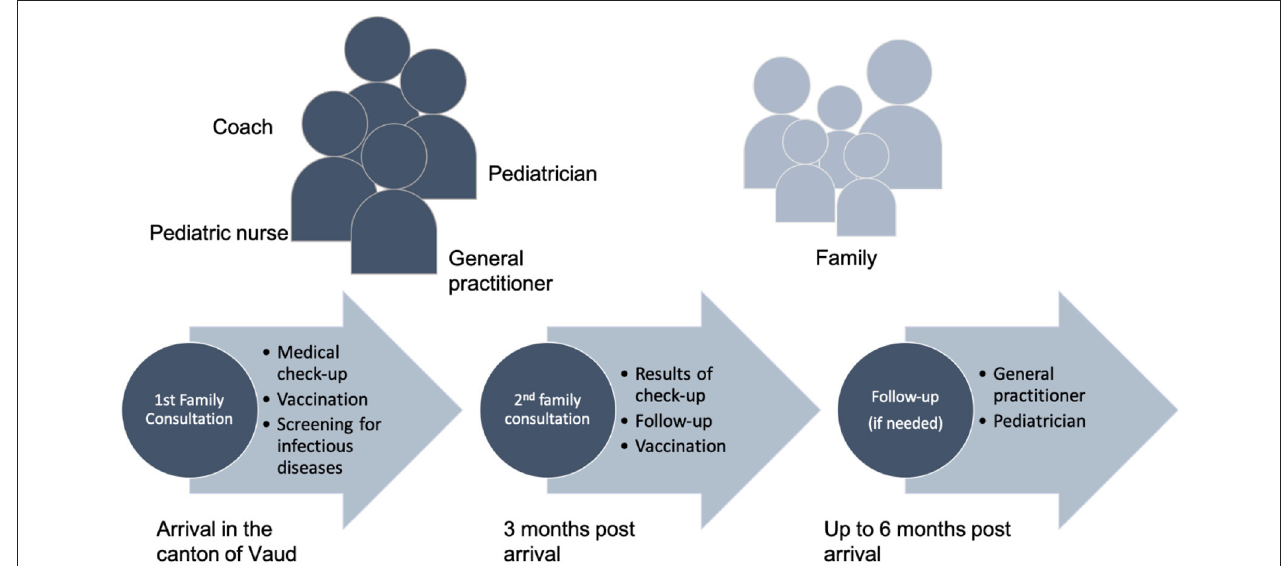
FIGURE 1 | The family